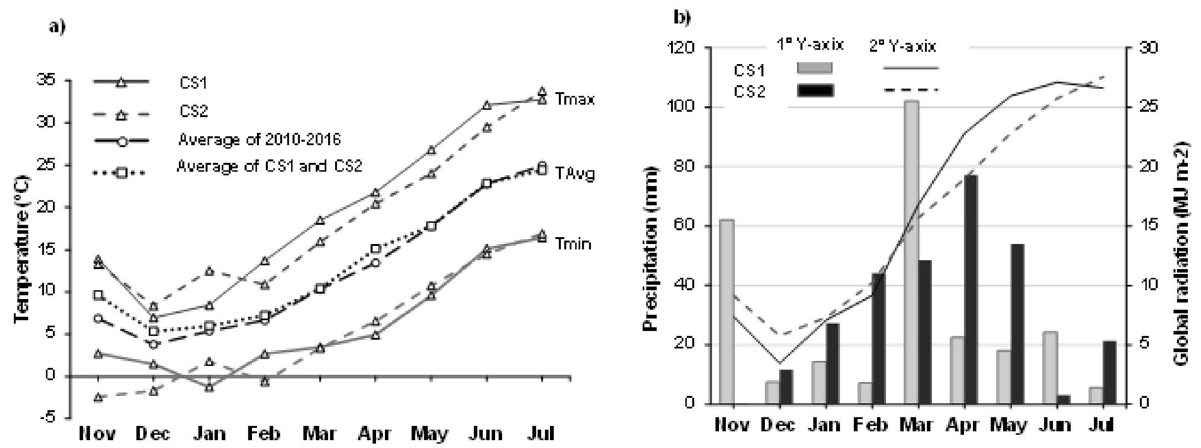
Figure 11. Monthly minimum (Tmin), maximum (Tmax) for first (CS1) and second (CS2) cropping season and mean of the monthly average temperature (TAvg) of CS1 and CS2 as well as monthly TAvg of cropping seasons from the past 5 years (2010–2016, a ); monthly accumulated precipitation and global radiation for CS1 and CS2 ( b Weather data were collected daily from Meteocat (agro-meteorological network of Catalonia, en.meteocat. gencat.cat) from a station located near the experimental site. The average temperatures from sowing to maturity